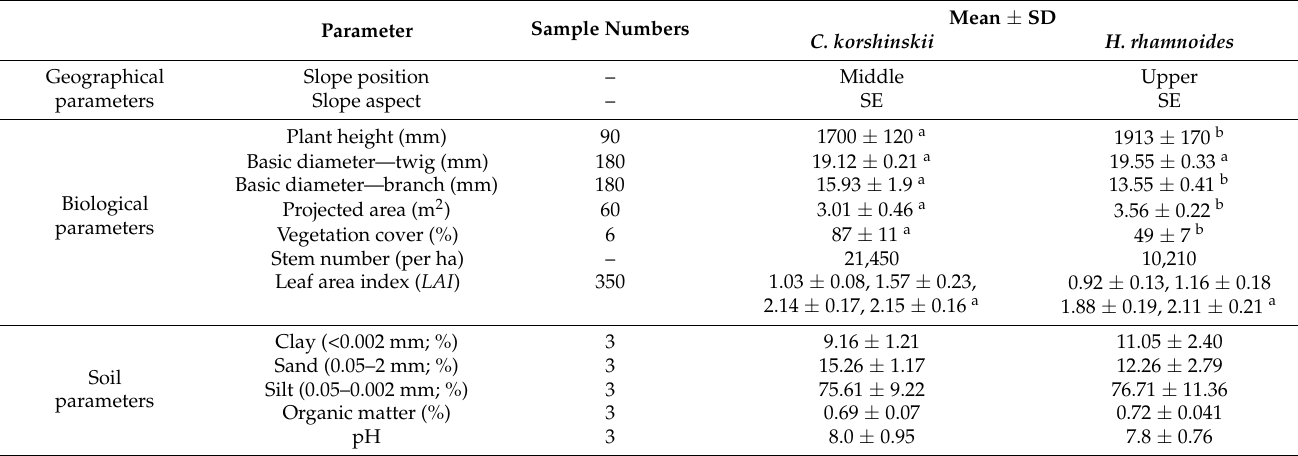
Table 1. The basic information of the C. korshinskii and H. rhamnoides plots. Parameter Sample